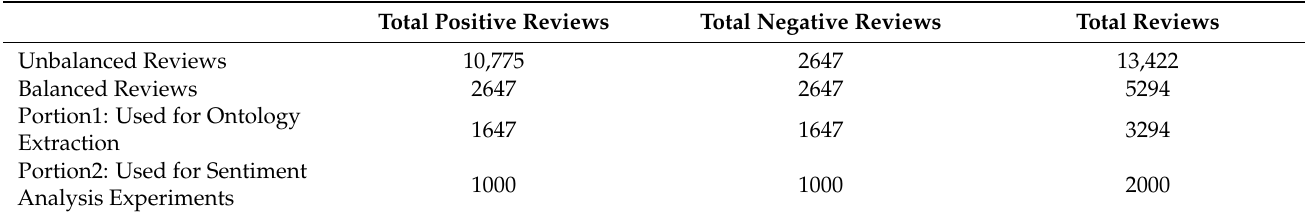
Table 10. Dataset statistics before and after class balancing.